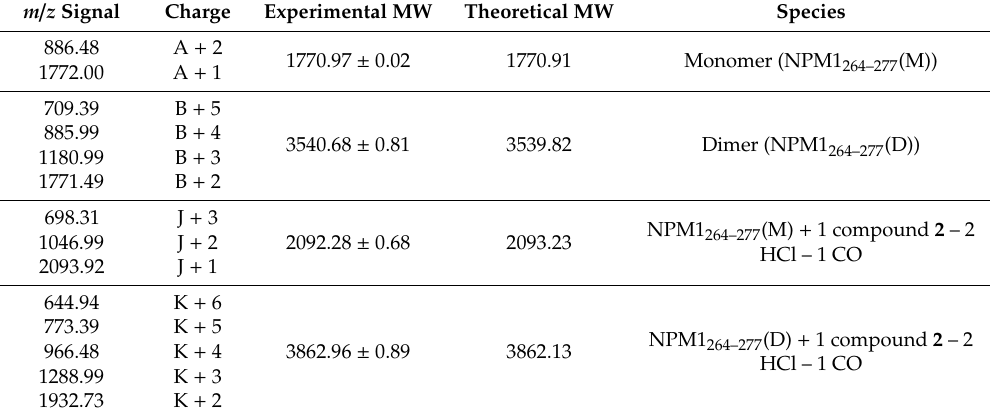
Table 2. ESI-MS detected species formed by NPM1 264–277 with irradiated compound 2 at 0 h of incubation. The experimental m / z values and their charge, the experimental and theoretical molecular weight, and the corresponding species are